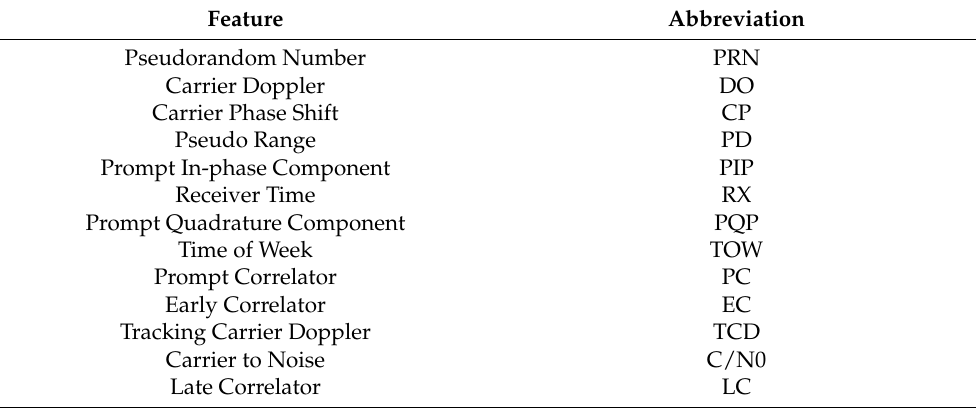
Table 2. List of features with their